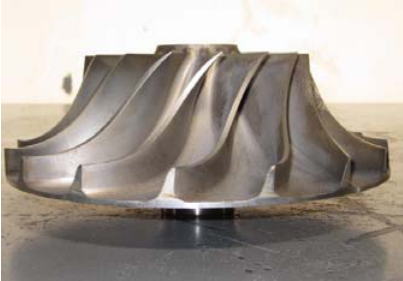
Figure 2. Structure of a semi-open impeller for a centrifugal